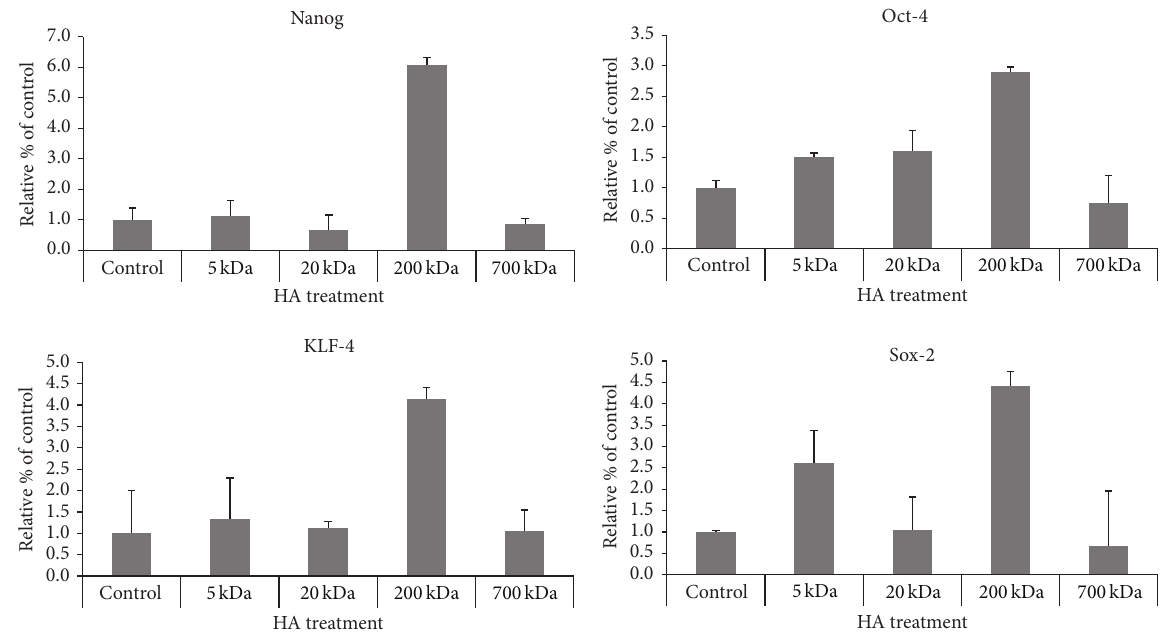
Figure 2: Effects of various sizes of HA on stimulating stem cell marker (Nanog, Oct4, Sox2, and KLF-4) expression in CD 44 v 3 high ALDH 1 high cells using Q-PCR